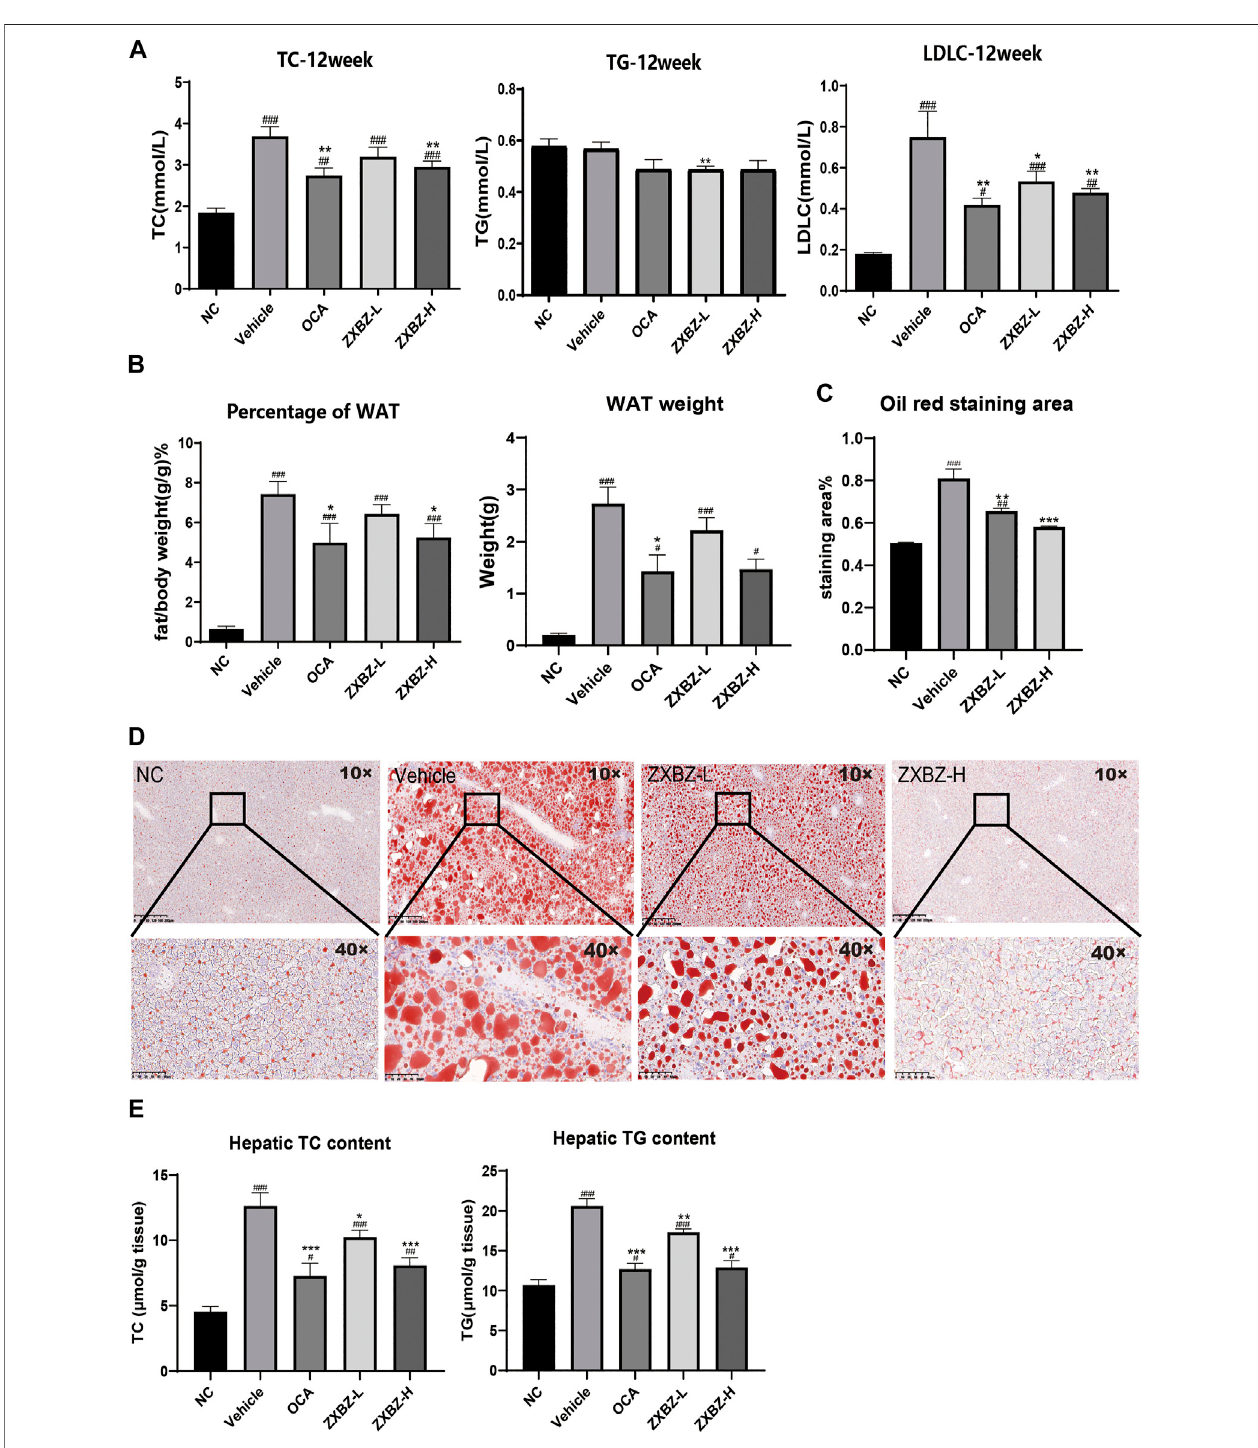
FIGURE5| ZXBZdecoctioncouldimprovethelipidmetabolisminNAFLDmice. (A) LevelsofTC,TG,andLDLCinserumafter12-weektreatment. (B) Percentage of white adipose tissue and white adipose tissue weight of each group. (C) The oil red staining area of liver tissues. The positive areas were calculated using Image Pro plus 6.0. (D) Oil red O staining of livers and quanti fi cation in NC, vehicle, ZXBZ-L, and ZXBZ-H groups. (E) The TC and TG contents in mouse livers and normalized by tissue weight. The data are the mean ± SEM ( n = 8 – 10 per group). # p < 0.05, ## p < 0.01, ### p < 0.001 compared to NC. * p < 0.05, ** p < 0.01, *** p < 0.001 compared to